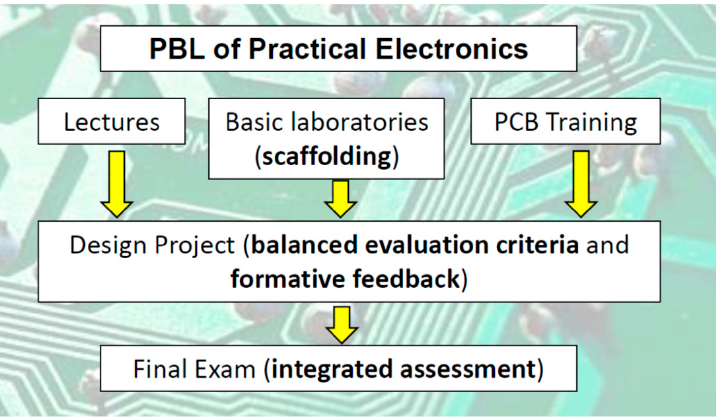
Figure 1. Course structure for Practical Electronics is provided. Additionally, the implementation of four effective strategies (in bolded text) is also